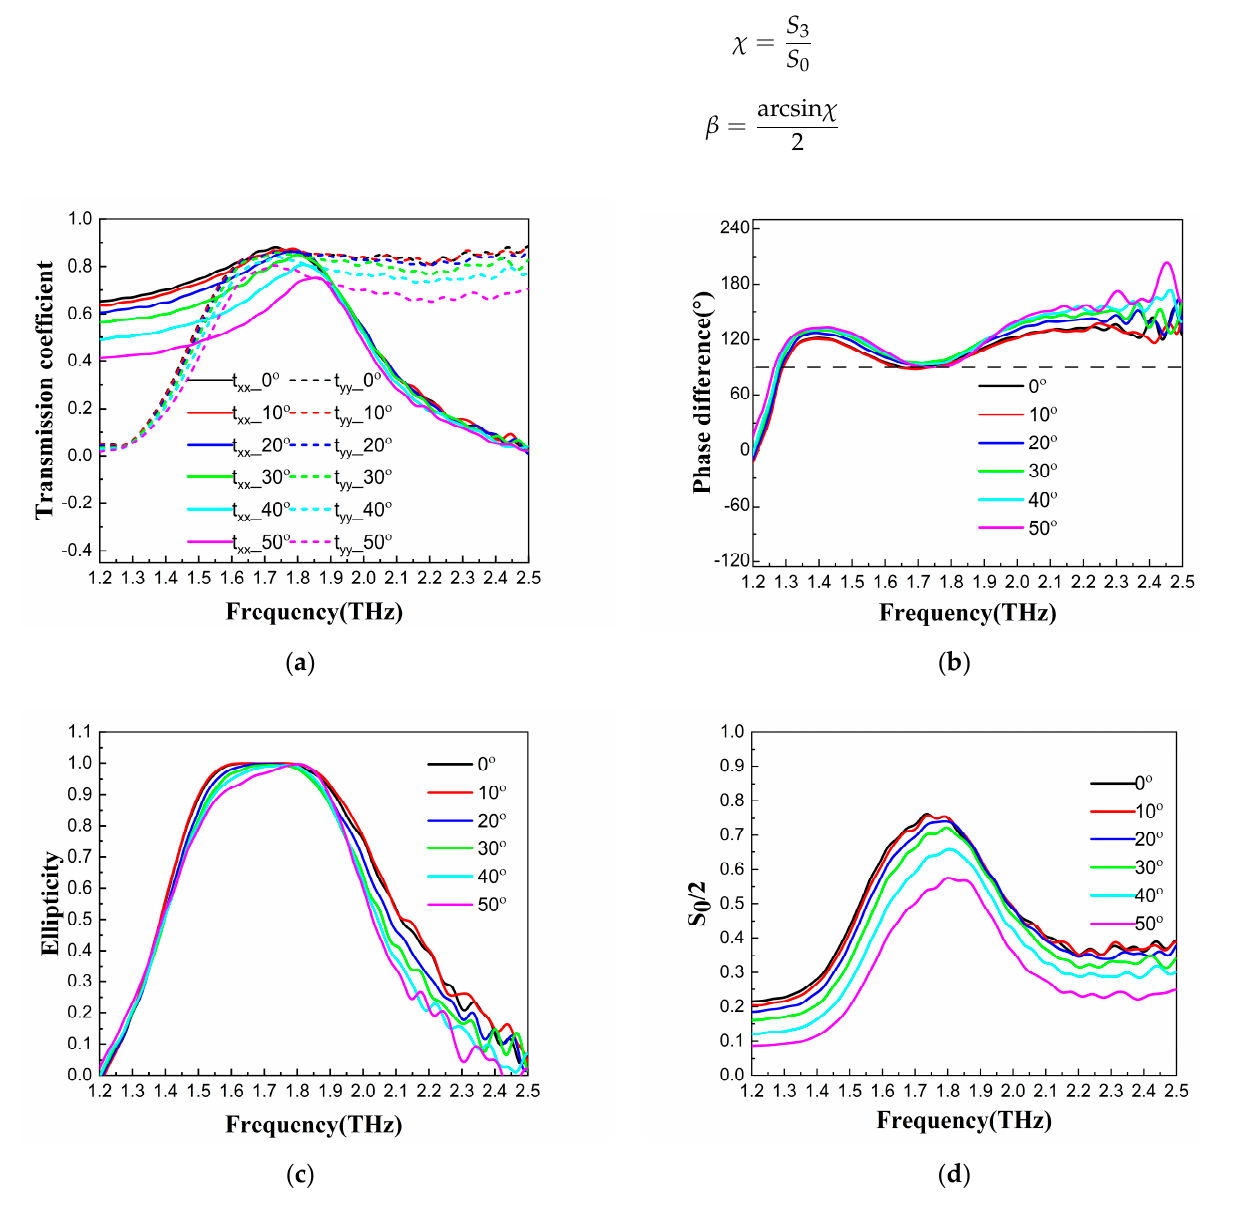
Figure 4. ( a ) Transmission coefficients, ( b ) phase differences, ( c ) ellipticities, and ( d ) S 0 /2 of terahertz waves in both the x- and y-directions at different incidence angles.